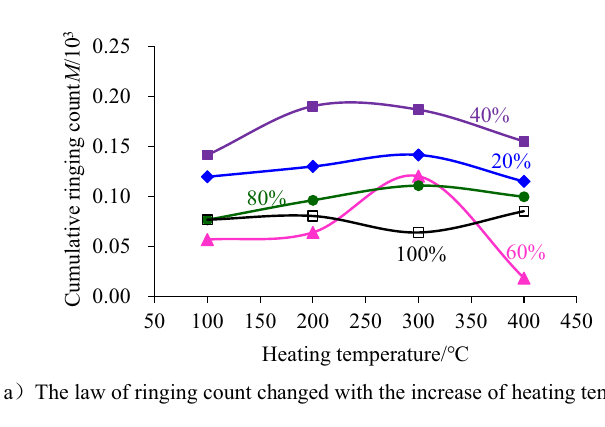
Figure 11. The change rule of accumulated amplitude of acoustic emission.